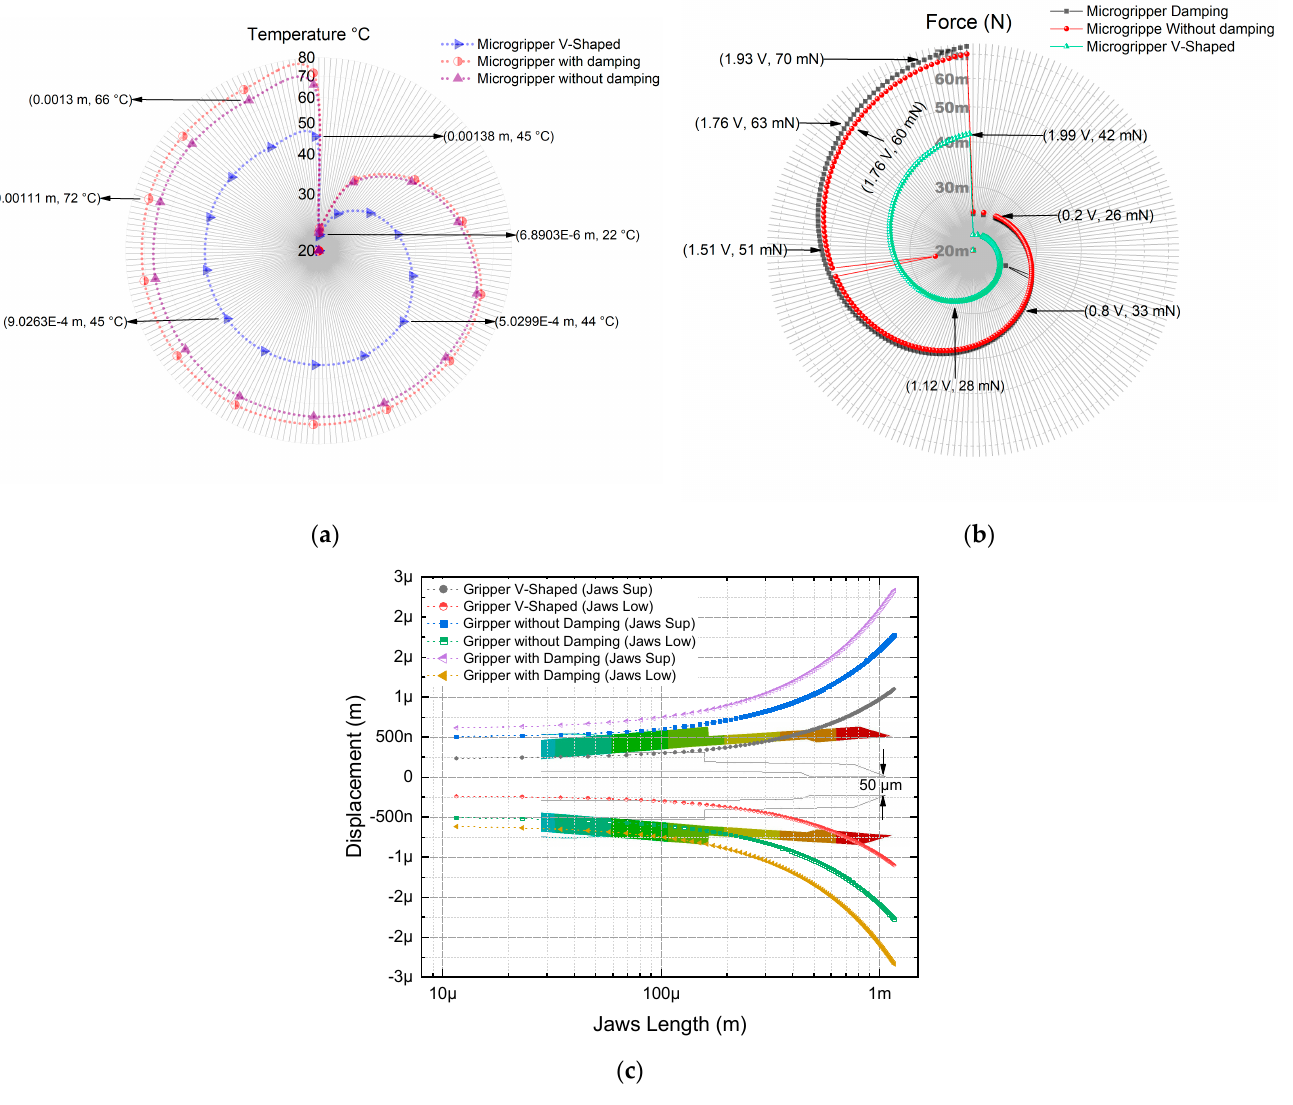
Figure 11. ( a ) Temperature distribution vs. length, ( b ) force vs. applied voltage, and ( c ) displacement vs. jaw length for the micro gripper with actuator 2, with and without damping elements, and with the V-shaped actuator. Table 10. Comparison of performance parameters of microgripper, obtained by simulation in AN- SYS.